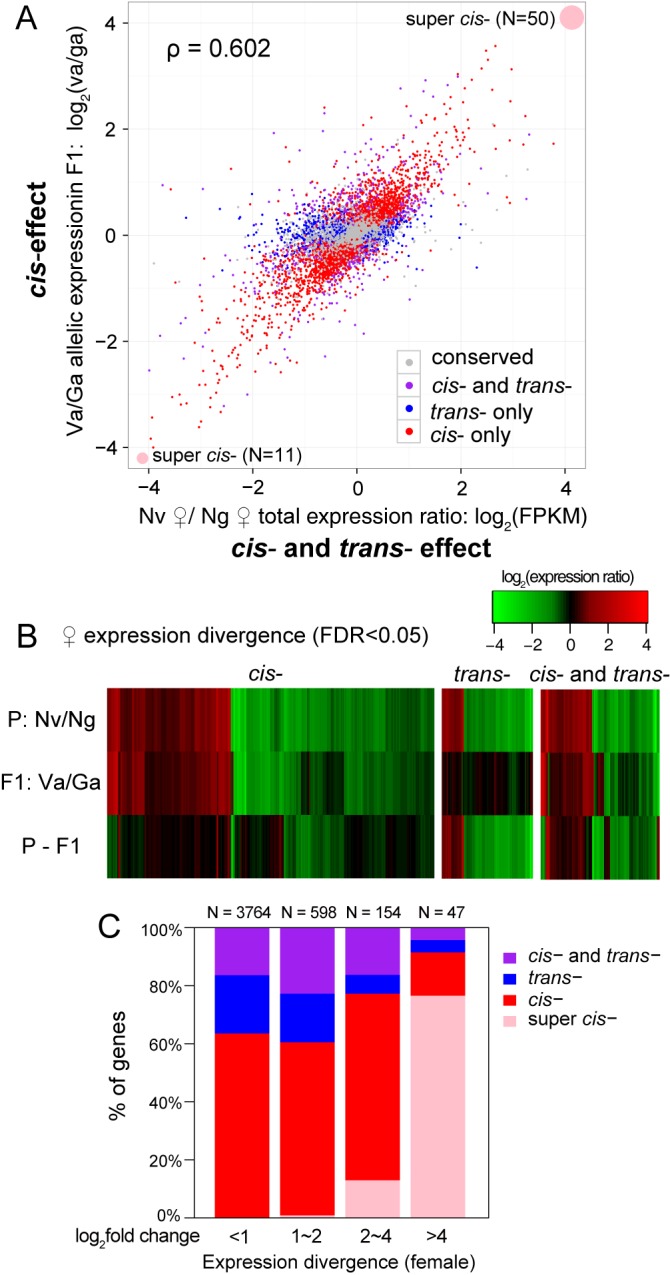
Relationship between cis- and trans- effect and expression divergence between N. vitripennis and N. giraulti.(A) Scatter plot of N. vitripennis and N. giraulti female total expression ratios (Nv/Ng) on the x-axis against average relative allelic expression from vitripennis allele (Va) and giraulti allele (Ga) in F1s on the y-axis. Conserved genes with no significant cis- or trans- effect are labeled in gray. cis- only, trans- only, and cis- and trans- genes are labeled in red, blue, and purple, respectively. Spearman's rank correlation coefficient ρ is labeled in the top left corner. Sixty-one genes with 100% monoallelic expression in at least one F1 sample are defined as super cis- genes and are represented by pink dots in the top right and bottom left corner. (B) Heatmap of genes with significant cis-, trans-, and cis- and trans- effects on female gene expression divergence. Only genes with significant female expression difference between N. vitripennis and N. giraulti are included (FDR < 0.05). (C) Stacked barplot showing the distribution of cis-, trans-, cis- and trans- and super cis- class genes for different categories of expression fold differences between N. vitripennis and N. giraulti for female expression divergence. Data presented in this figure can be found at http://dx.doi.org/10.5061/dryad.qf2t8.